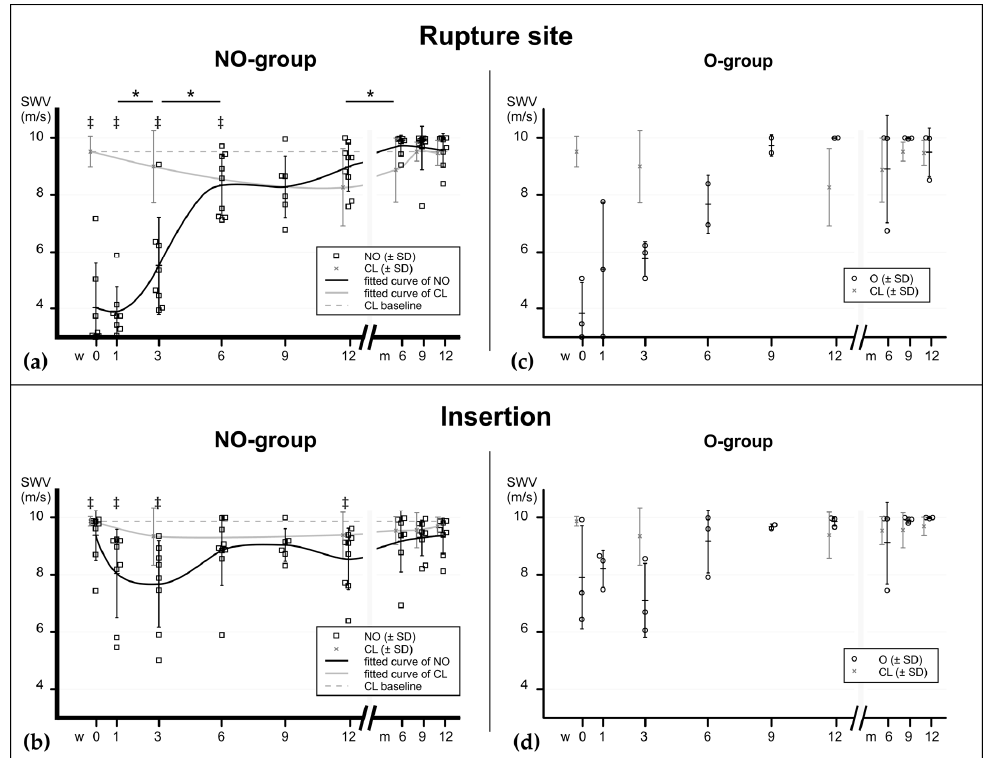
Figure 2. Material elastic properties during tendon healing at the rupture site and insertion, assessed with SWE, expressed in m/s. The graphs show the progression of elastographic stiffness in relation to time after injury (0–12 weeks and 6–12 months). ( a ) In the mainly invested group—the non-operatively treated patients—the elastographical pattern at the rupture site shows a bi-sigmoidal increase (fitted curve line) with a major increase between the third and the sixth week, suggesting an early regaining of material elastic properties. Another less substantial increase occurs after the ninth week, at the end of the consolidation phase. Interestingly, the biomechanical properties of the contralateral tendons (grey line) drops during the first 12 weeks before increasing back to baseline values. ( b ) At the insertion site the decrease of material elastic properties is less substantial due to the continuity of tendon tissue in this area. Significant differences between the consecutive time points of the NO-group are noted with asterisks (*). ‡ show significant differences between the ruptured tendons (NO) and baseline values (CL at time of injury, dashed baseline) at the corresponding time points. p values: * ≤ 0.05. ( c ) + ( d ) Elastographic values of operatively treated patients for comparison. NO = non-operatively treated patients, O = operatively treated patients, CL = contralateral tendons (pooled).